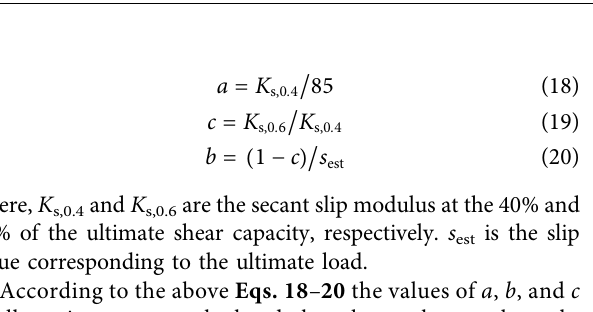
Frontiers in Materials |